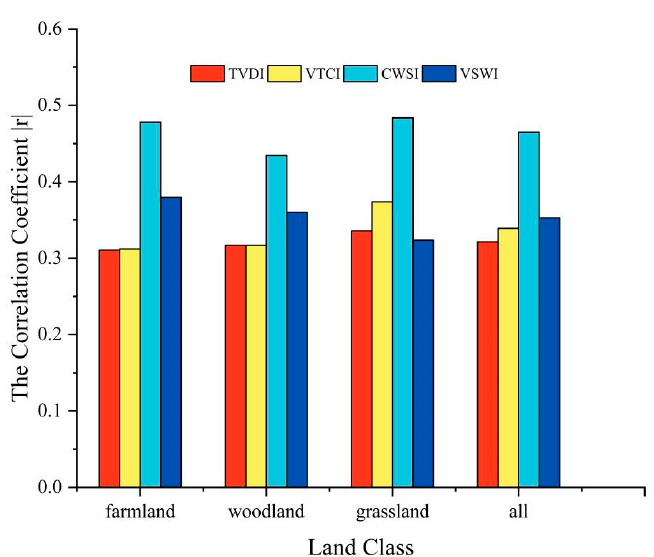
Figure 4. Correlation coefficient between remote-sensing drought index and sc-PDSI in different vegetation zones in 2001–2020.